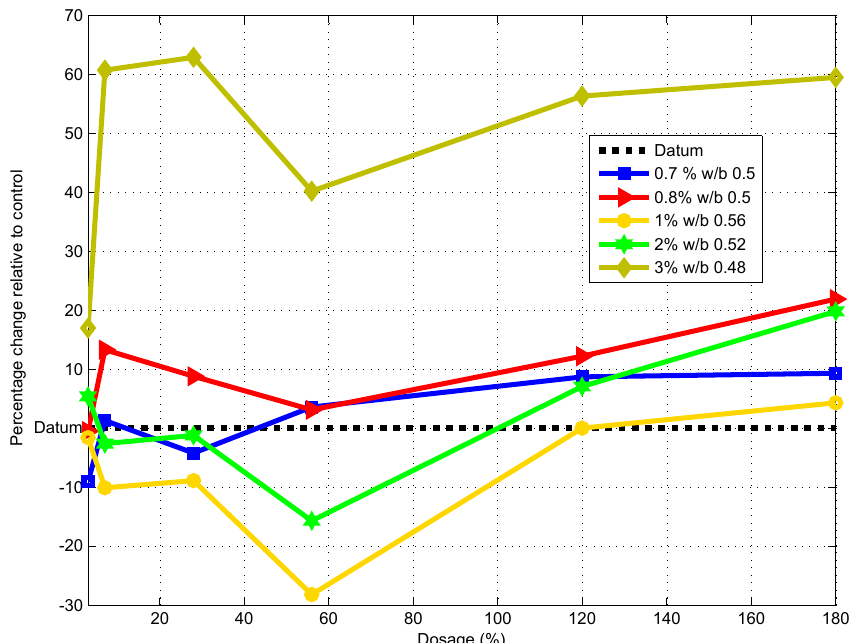
Figure 8. Percentage change in compressive strength with reduced water compared to the